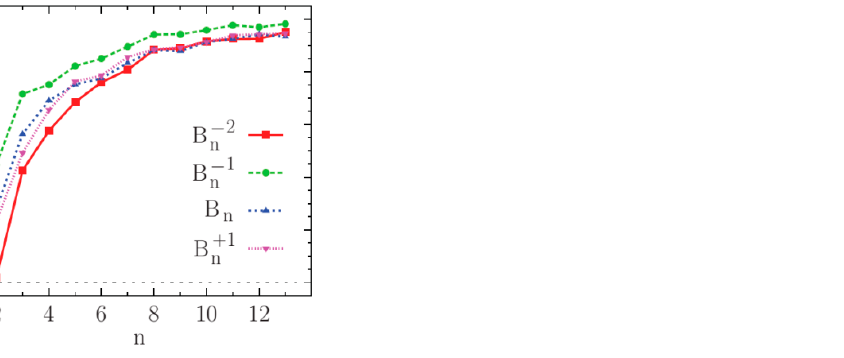
Figure 4. Binding energy per atom of neutral and ionized boron clusters as function of size [70], Copyright (2011), with permission from American Physical Society.